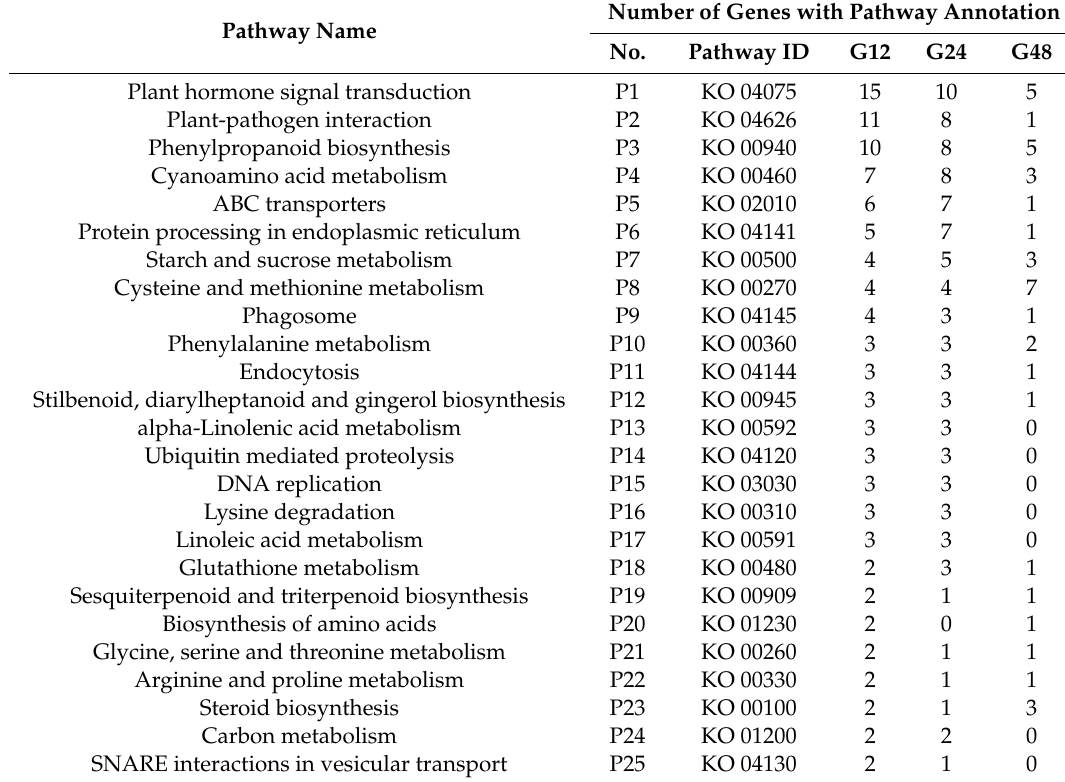
Table 2. Results of Kyoto Encyclopedia of Genes and Genomes (KEGG) pathway enrichment